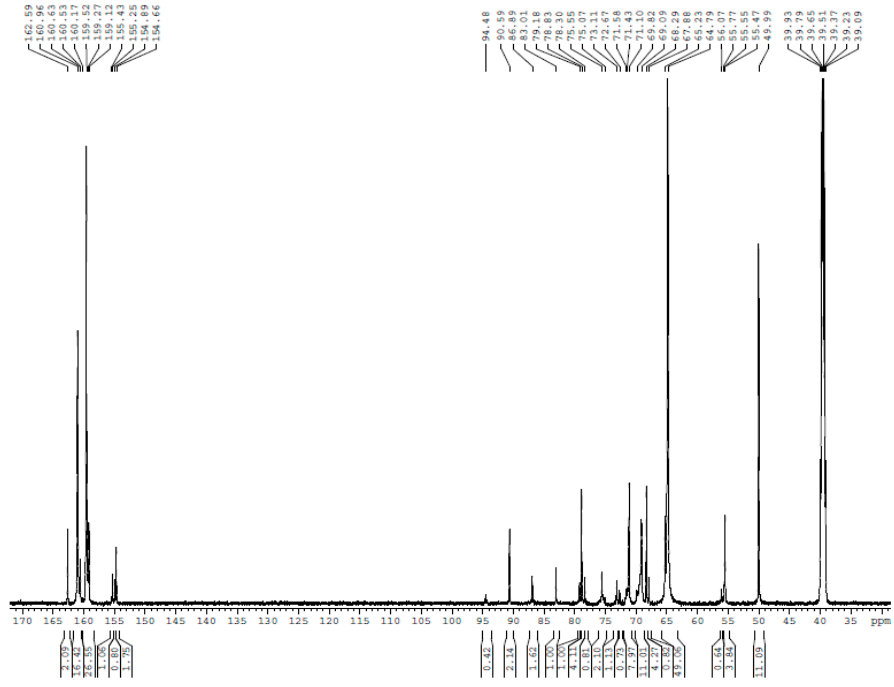
Figure 1. The 13 C nuclear magnetic resonance ( 13 C NMR) spectrum of sample UF-1.